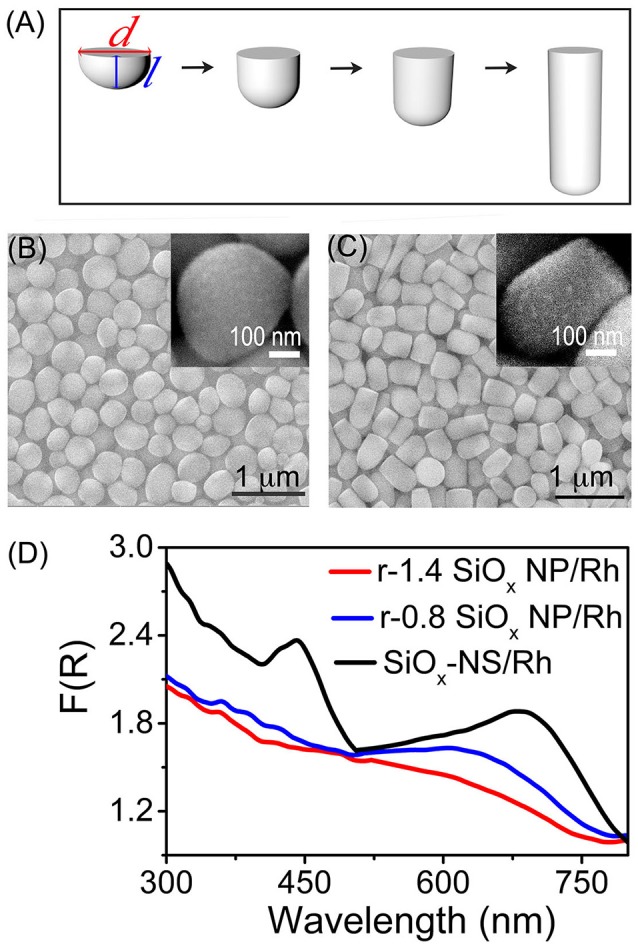
(A) Schematic illustration of the geometry of r-SiOx NPs with different aspect ratios. The aspect ratio is defined by the ratio of the length (l) to the width (d) of an r-SiOx NP. (B,C) SEM images of the r-SiOx NPs with aspect ratios of 0.8 (denoted as r-0.8 SiOx NPs) (B) and 1.4 (denoted as r-1.4 SiOx NPs) (C). The insets present the SEM images of the r-SiOx NPs covered with Rh nanocrystals. (D) DRS spectra of powders of the silica nanoparticles (SiOx NSs, r-0.8 SiOx NPs, and r-1.4 SiOx NPs) with 2 wt.% loading of Rh nanocrystals.